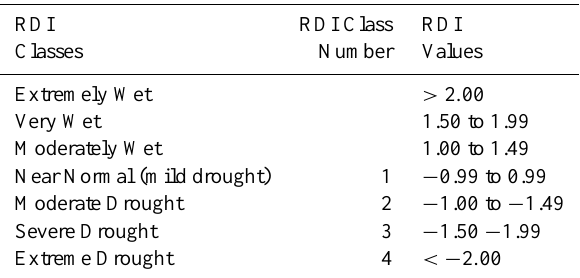
Table 2. Drought classes based on RDI (Tsakiris and Vangelis,